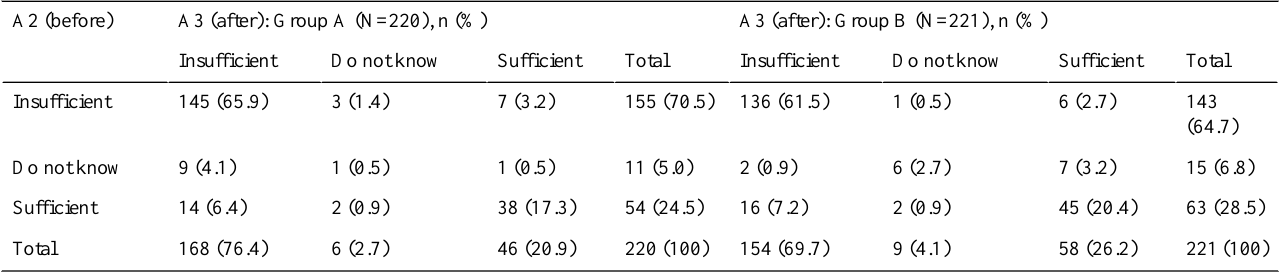
Table 10. Presentation of the contingency table (A2 a vs A3 b ) before and after the clarification of quality principles and the targeted search for these quality